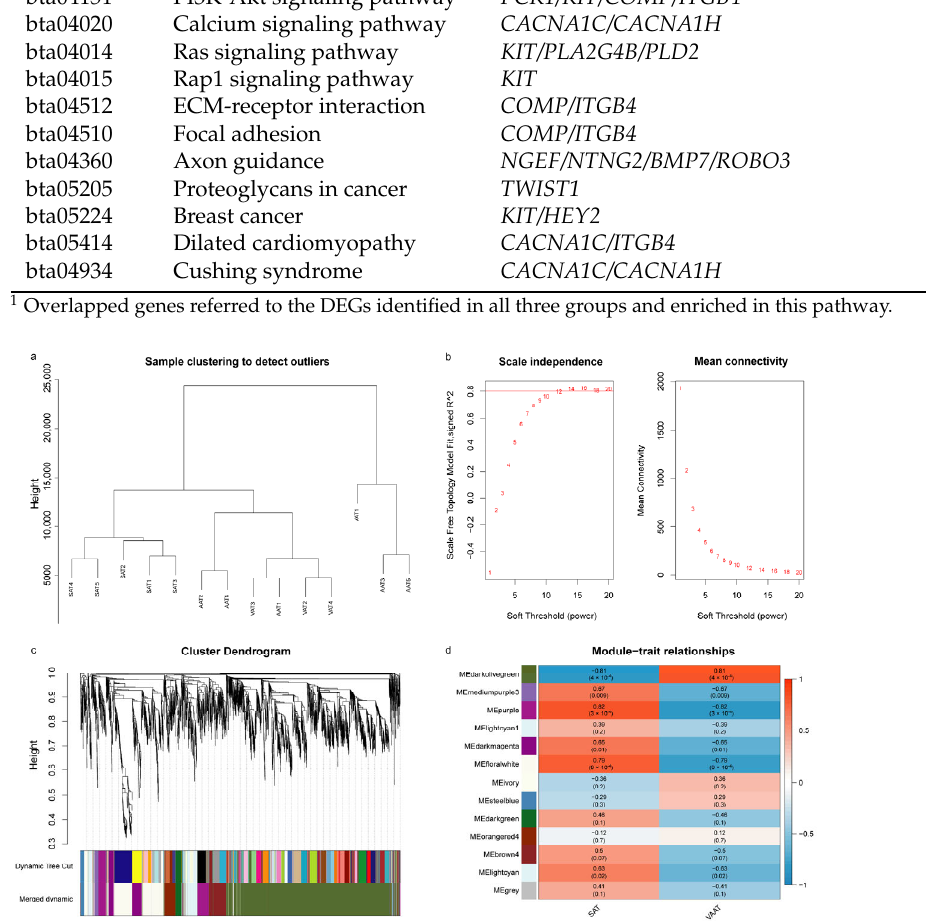
Figure 5. Weighted gene co ‐ expression network analysis. ( a ) Sample cluster diagram; ( b ) Soft threshold calculation; ( c ) Functional module division; ( d ) Relationship between gene modules and adipose tissues. The value outside the parentheses expresses Pearson’s correlation coefficients between the module eigengenes and adipose tissues, and the number within the parentheses is the p ‐ value.